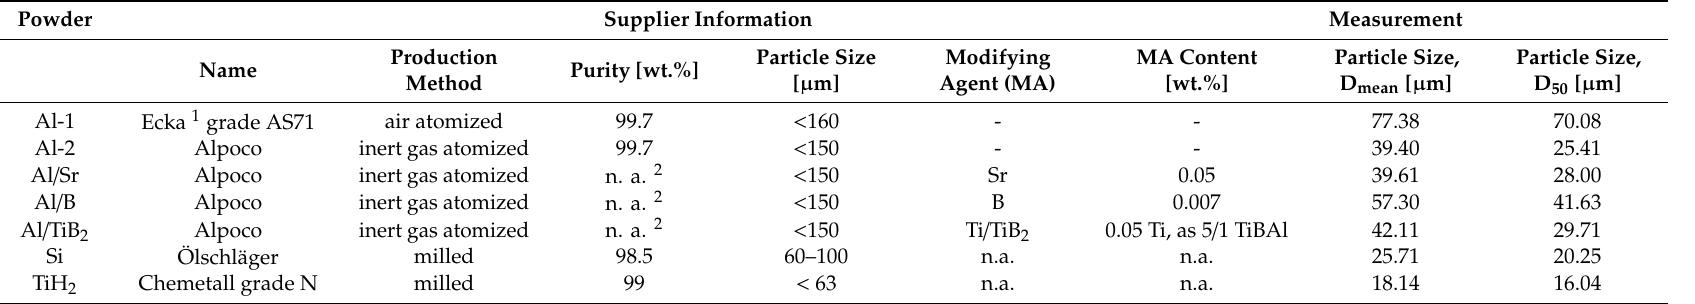
Table 1. Composition, production method and supplier of powder